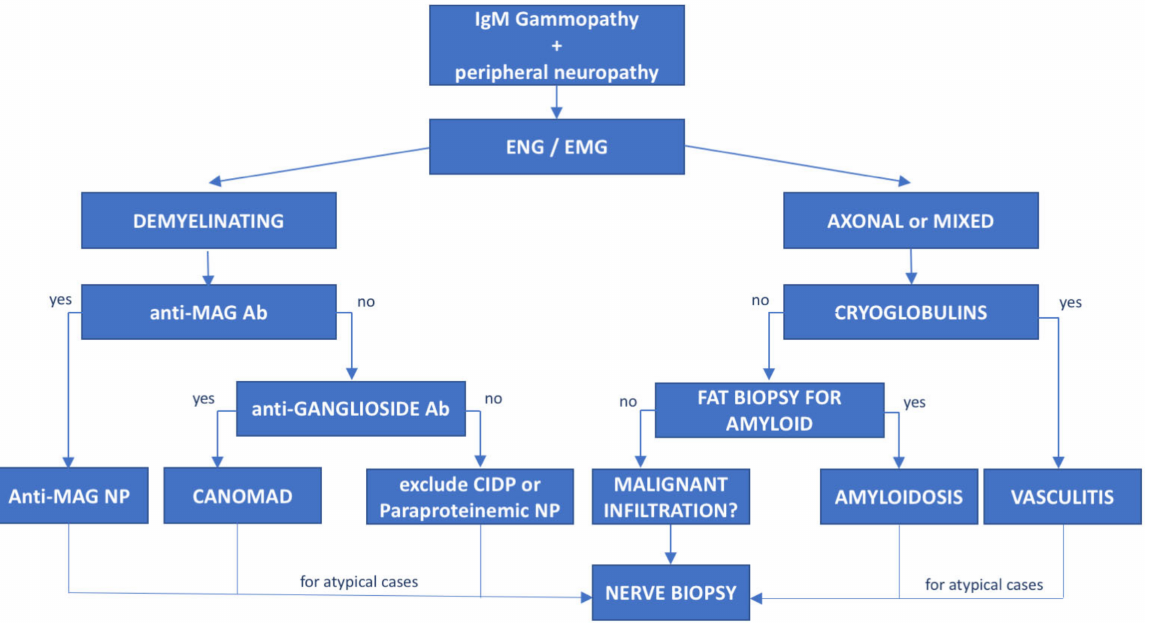
Figure 2. Diagnostic flowchart of peripheral neuropathy associated with IgM monoclonal gam- mopathy. Patients with IgM monoclonal protein and peripheral neuropathy diagnosed with neu- rophysiological tests (electroneurography (ENG) and electromyography (EMG)) should undergo further investigation based on the type of neuropathy. Demyelinating cases with prolonged distal latency must be tested for anti-MAG antibodies to rule out anti-MAG neuropathy; negative cases with chronic ataxia and ophthalmoplegia must be tested for antiganglioside antibodies to exclude CANOMAD diseases. In double-negative patients, CIDP and paraproteinemic neuropathy should be taken into consideration. On the other hand, for patients with axonal or mixed (axonal and demyeli- nating features) neuropathies, cryoglobulins and light-chain amyloid deposition in fat biopsy should be investigated. However, for atypical or rapidly progressive cases, nerve biopsy is recommended to exclude neurolymphomatosis. Ab—antibodies,